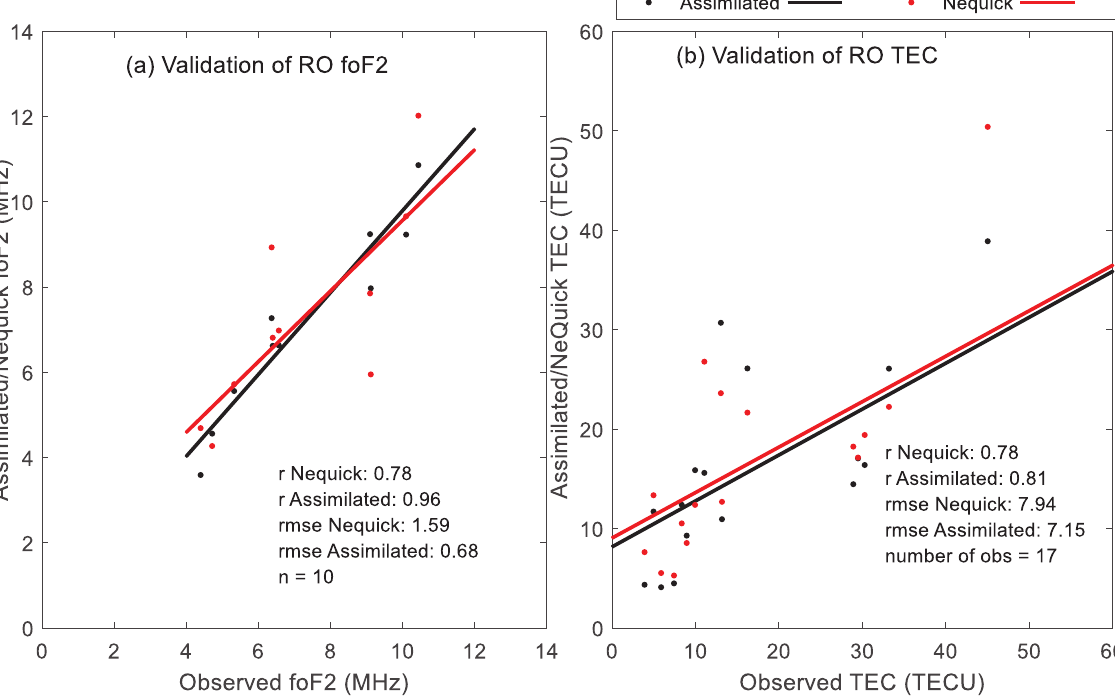
Figure 9. Panel (a) presents scatter plot of foF2 obtained from NeQuick model (red) and assimilation (black) as a function of coincident observed foF2 over the ionosonde stations considered in this study. Panel (b) presents scatter plot of TEC obtained from NeQuick model and assimilation as a function of coincident observed TEC over KGNI, TCMS, YONS, and BJFS GPS receiver stations. The data plotted are those on the days of the study